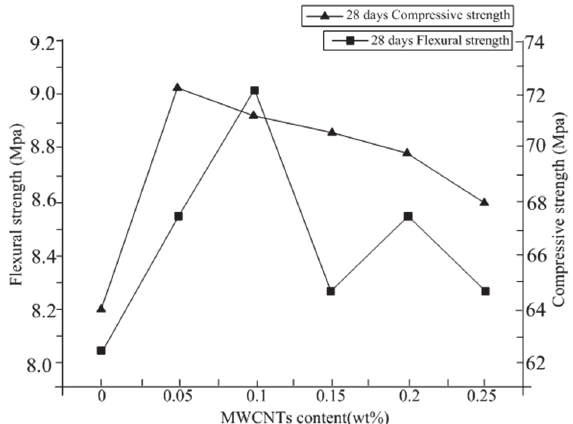
Figure 5: The mechanical properties of cement-based composite materials test specimens which were mixed with different amount of carbon nano-tubes after 28 days of